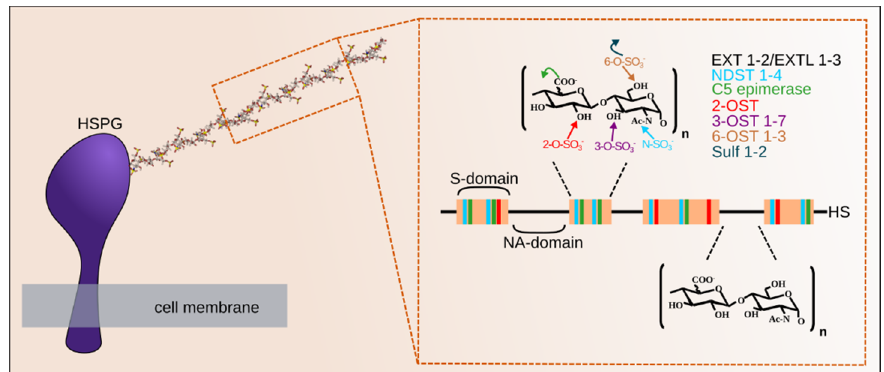
Figure 2. Heparan sulfate (HS) is a linear polysaccharide in which a glucuronic acid- N- acetyl glucosamine (GlcA-GlcNAc) repeat is polymerized by the exostosins (EXTs) enzymes and modified in restricted domains (S-domain, in red) through the action of the N- deacetylase/ N- sulfotransferase enzymes (NDSTs), C5 epimerase, 2-, 3- and 6- O- sulfotransferases (OSTs). These enzymes, localized within the Golgi apparatus, generate up to (the theoretical number of) 48 different disaccharides (23 of which have been identified yet), the combination of which gives rise to hyper variable structures spaced apart by more regular N- acetylated (NA)-domains (in black). Bound to a core protein to form HSPG, the proteoglycan is exported to the cell surface or the extracellular matrix, where Sulfs can further modify the polysaccharide. Both the sulfated (S)- and NA- domain organization of the HS chains and the extensive variability within the S domains provide the polysaccharide with distinct binding sites for its various protein ligands.